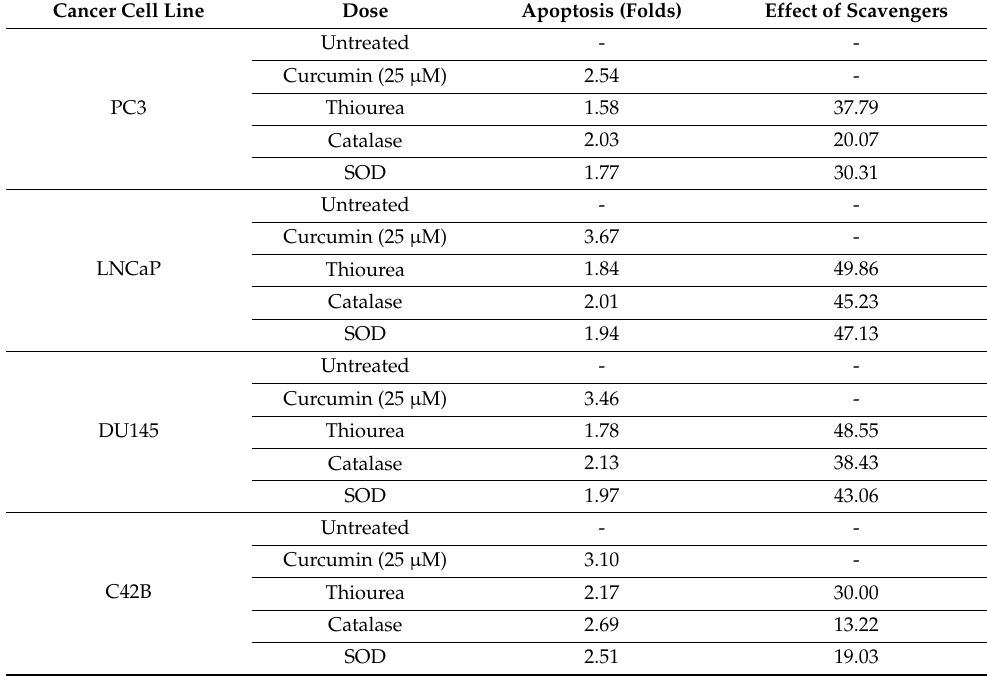
Table 2. Effect of ROS scavengers on curcumin activity in prostate cancer cell lines.